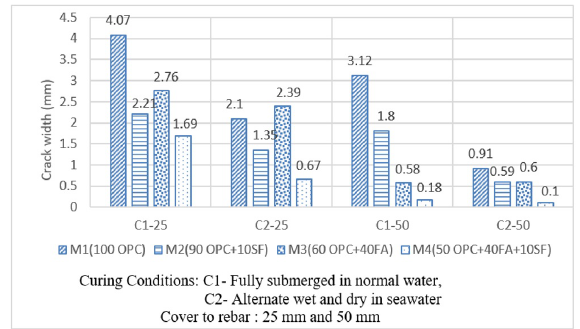
Fig. 8. Crack width (mm) at the end of 15 days ACT after